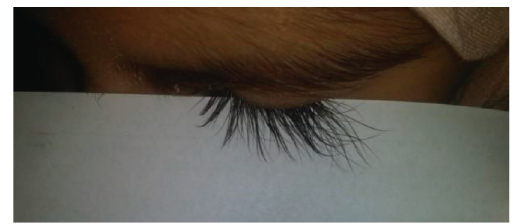
Figure 1: Eyelash trichomegaly in SLE patient.